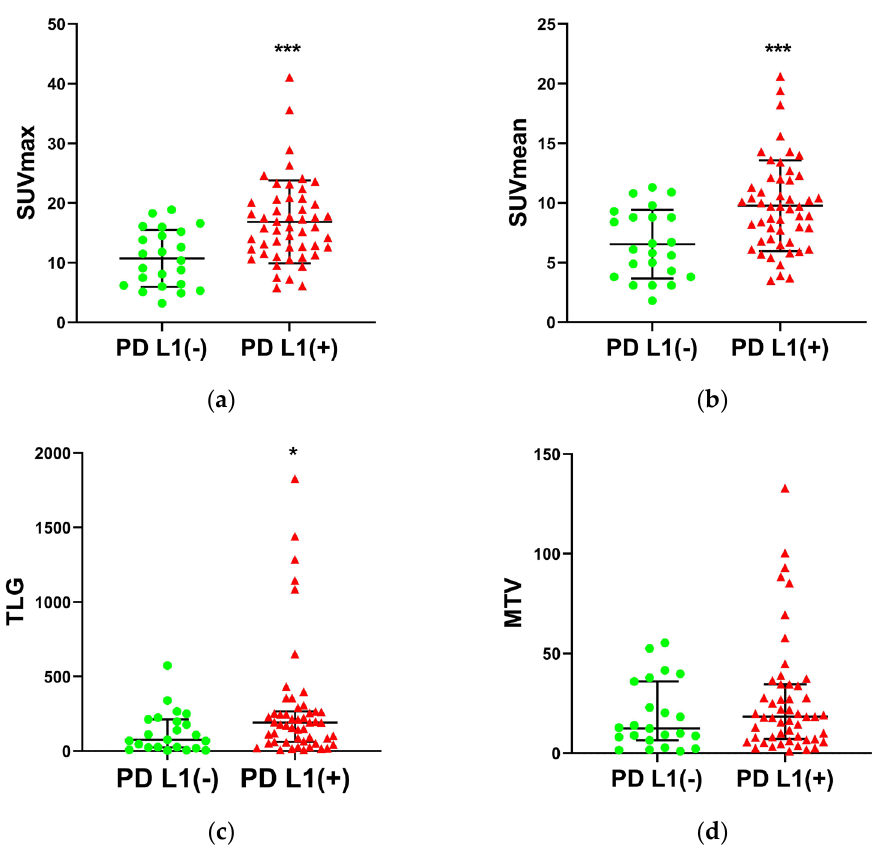
Figure 1. Comparison of SUVmax ( a ), SUVmean ( b ), TLG ( c ) and MTV ( d ) with PD-L1 status (* p < 0.05, *** p < 0.001). (* p < 0.05, *** p <